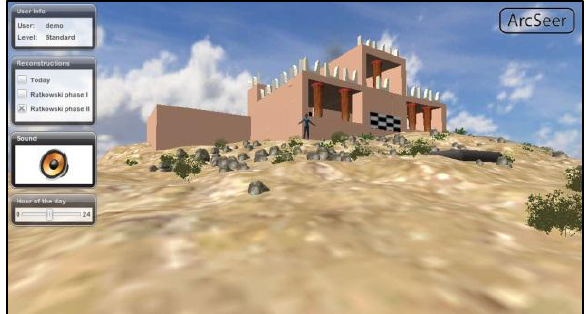
Figure 7: Reconstruction layer turned on in the ArcSeer Petsofa